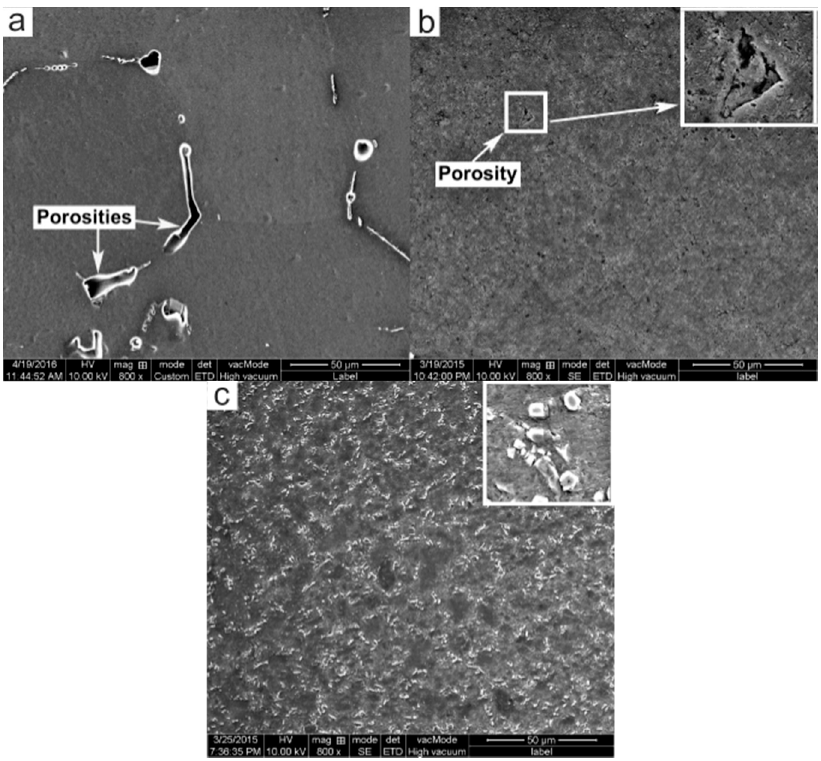
Figure 4. SEM images showing porosities in: ( a ) PMC-6061 alloy; ( b ) PTF-6061 alloy; ( c ) PTF-SiCp/6061Al composite.